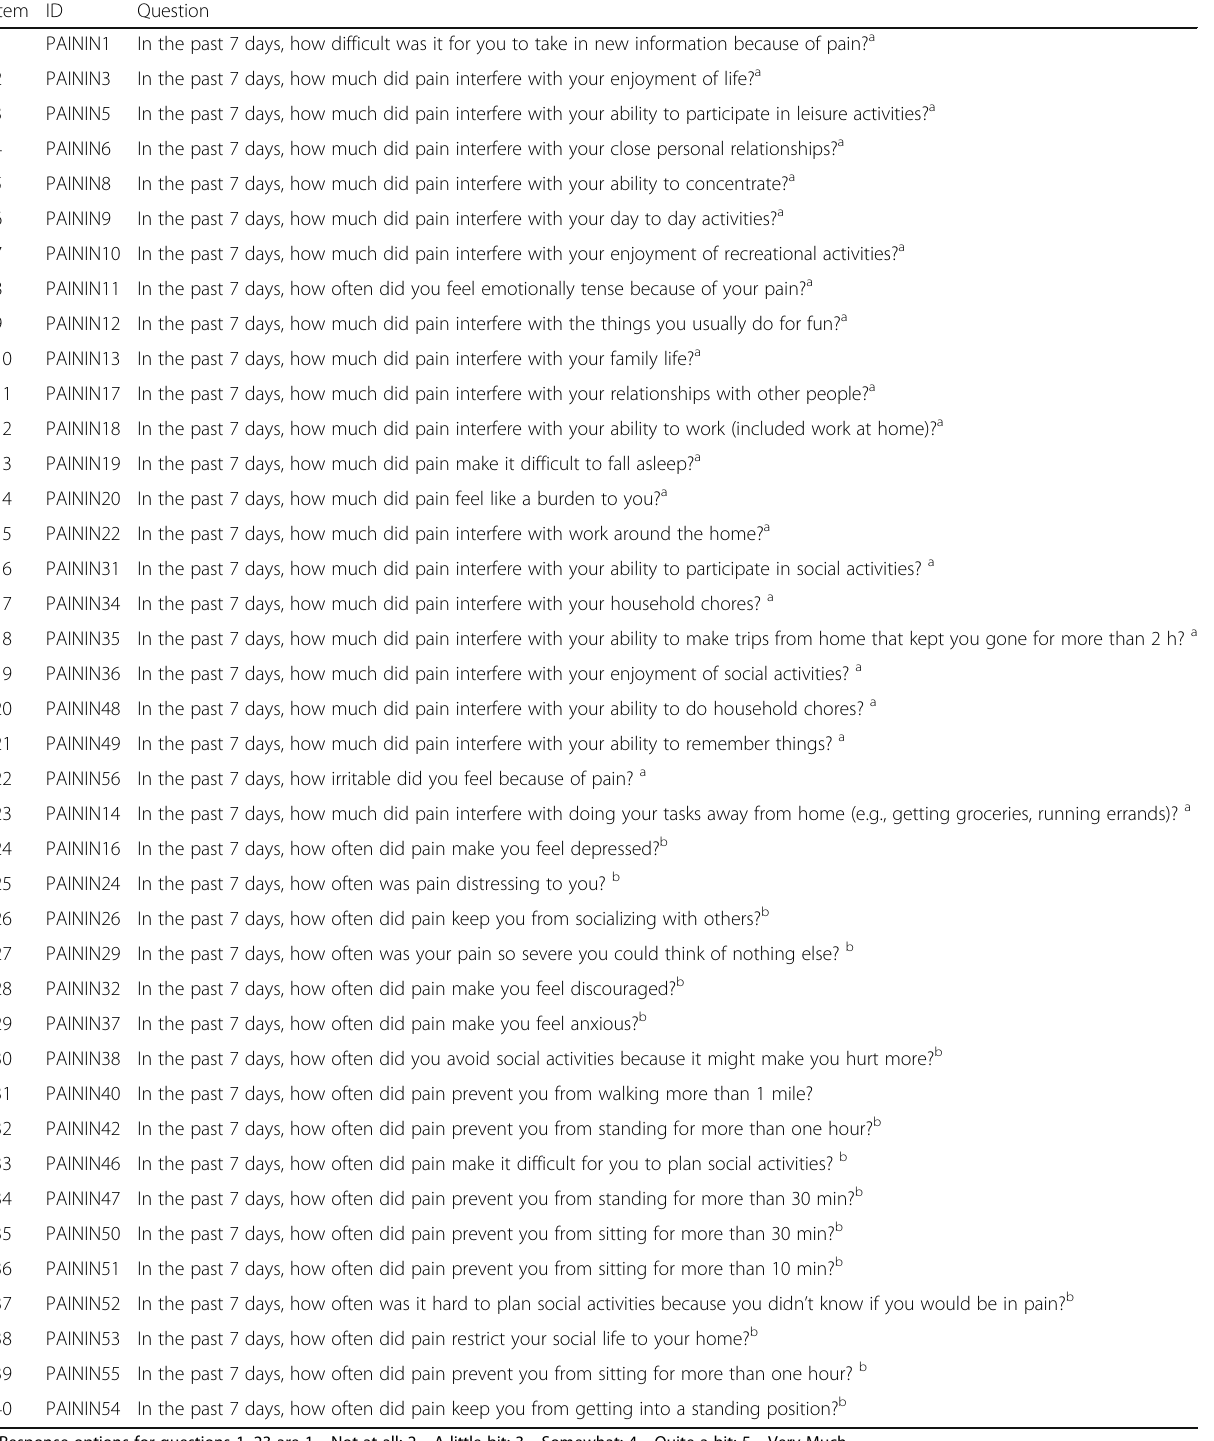
Table 7 PROMIS v1.1 Pain Interference item